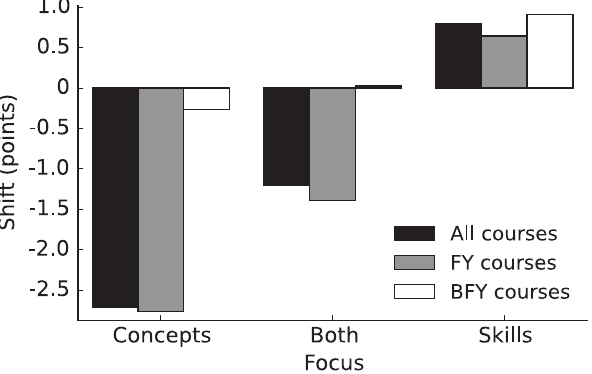
FIG. 1. Visual representation of pre- to postinstruction shifts in E-CLASS scores from all courses in the data set, as well as for the FY and BFY courses individually. Differences in the pre- and postinstruction score distributions are statistically significant in all cases except for those of the BFY students in the